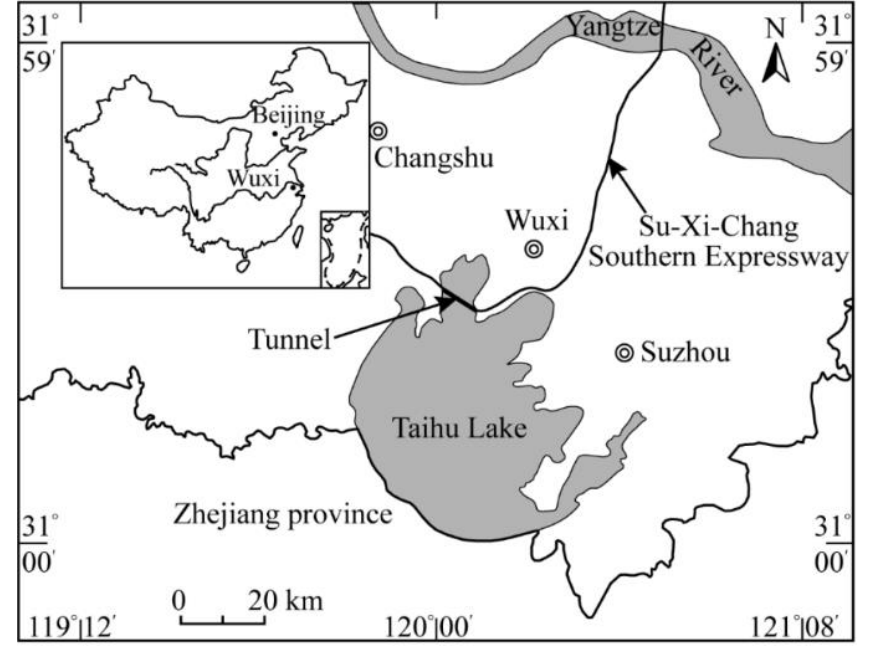
Figure 1. Location of the SBPM test site.